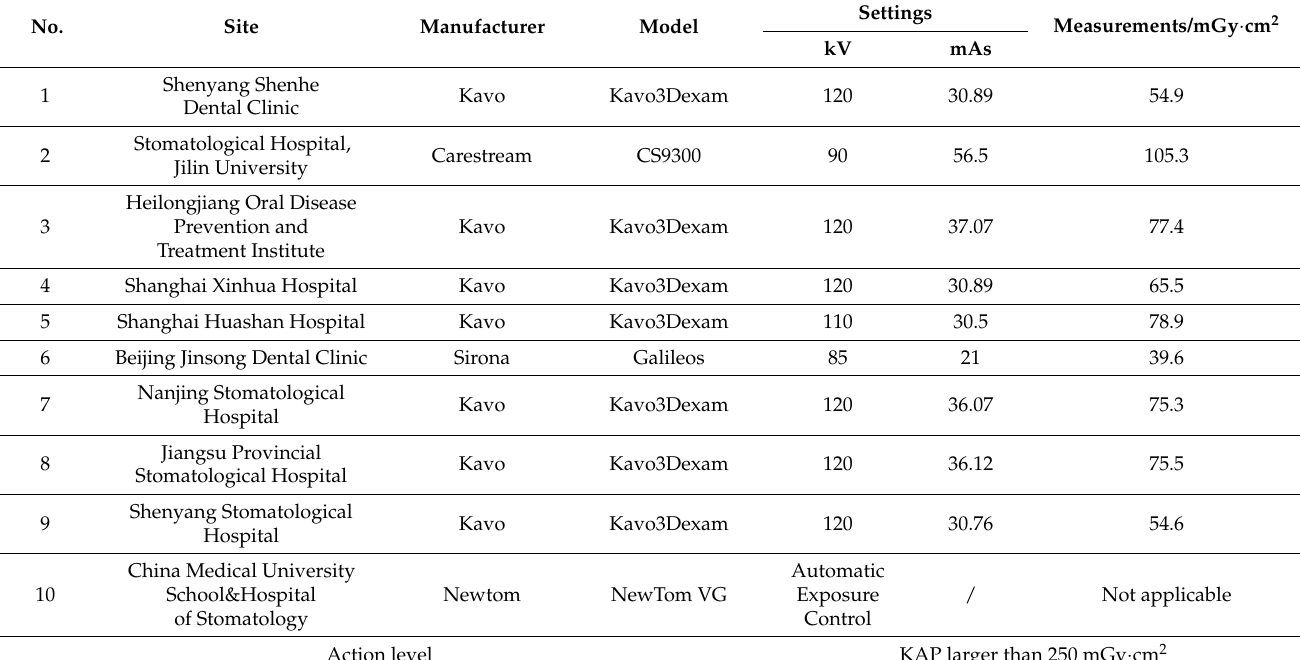
Table 1. Determination results of